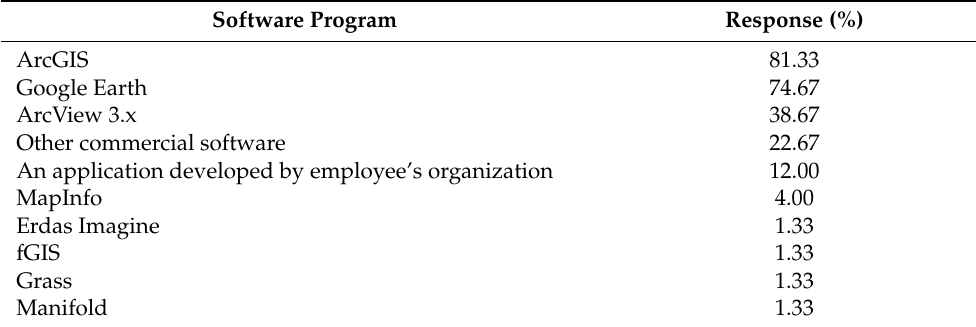
Table 1. GIS software used by recent graduates from forestry programs at Mississippi State University, Oregon State University, and the University of Georgia.